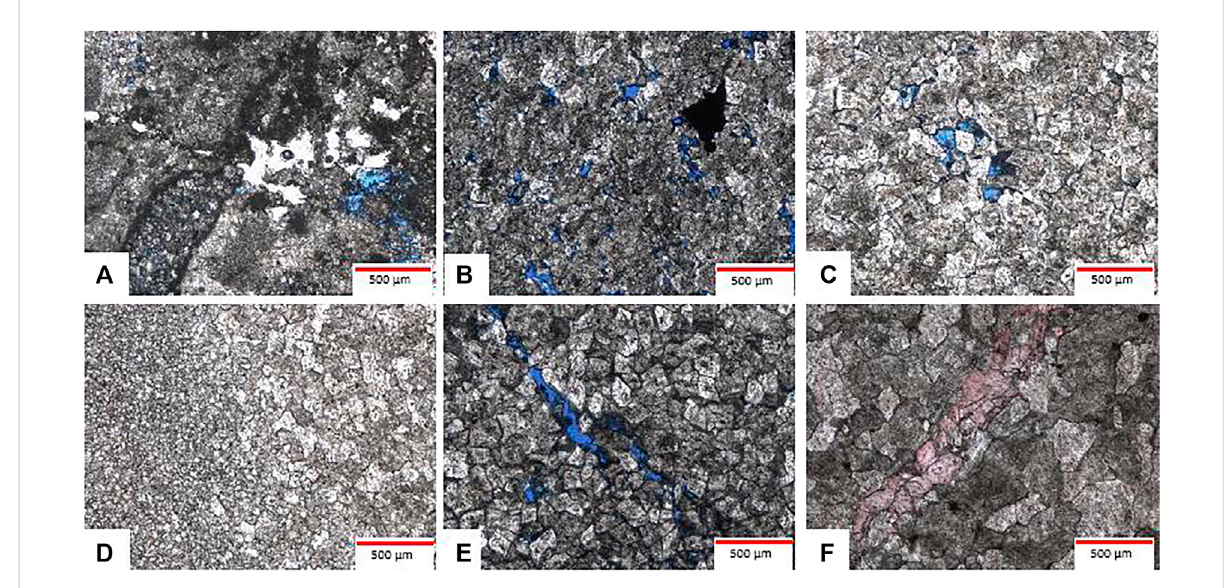
FIGURE 2 Microscopicpetrological characteristics of experimentalsamples.Silty-crystalline dolomitic limestone, MB1,6007.32 m, ∈ 2, thin sections, plane polarized light, ×50 (B) residual fi ne-crystalline dolarenite, BT5, 5,785.95 m, ∈ ; (C) silty-crystalline dolomite, DG1, 6,260.1 m, ∈ , thin sections, plane polarized light,×50 (D) silty-crystalline dolomite, DG1,6260.1 m, ∈ , thin sections, plane polarized light, ×50; (E) fi ne-grain dolomite, XH2,5353.93 m, ∈ 3, thin sections, plane polarized light, ×50; (F) medium-crystalline dolomite, YQ6, 7,116.9, ∈ 3, dying cast thin sections, plane polarized light, ×50.